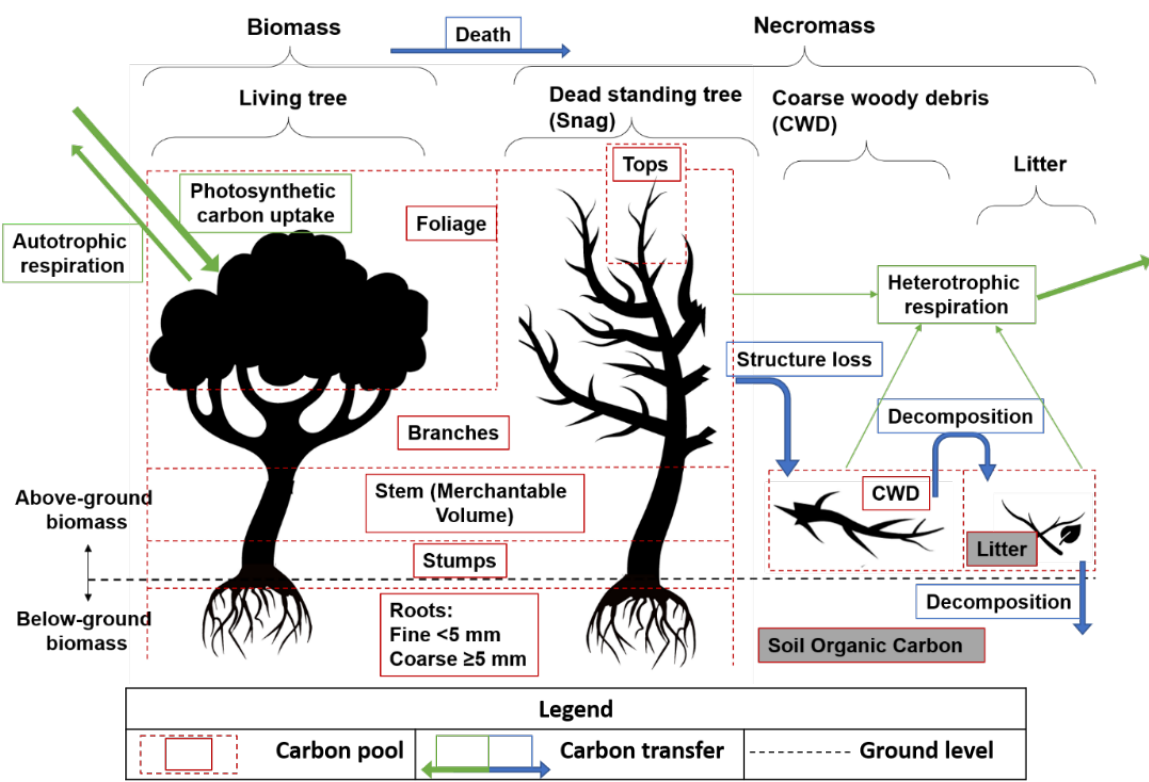
Figure 1. Tree compartments and plot-level carbon pools to be estimated from Permanent Sample Plot data. Shaded pools are not considered in the analysis. Tree compartments are not shown to scale.